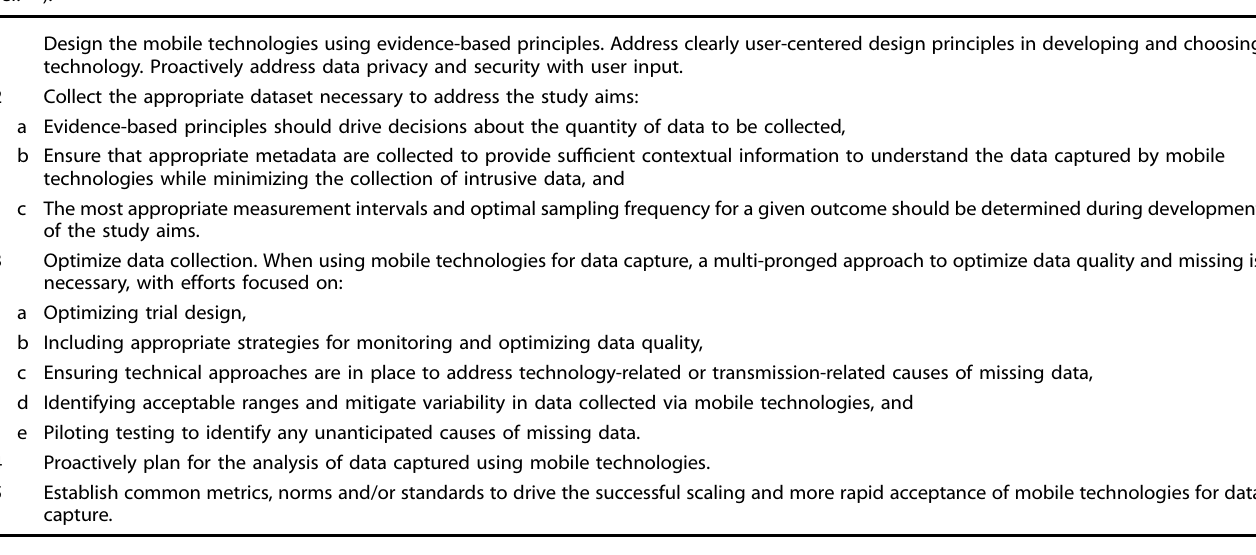
Table 1. Clinical trials transformation initiative (CTTI) recommendations for dealing with data collection from mobile technologies (Adapted from ref. 41